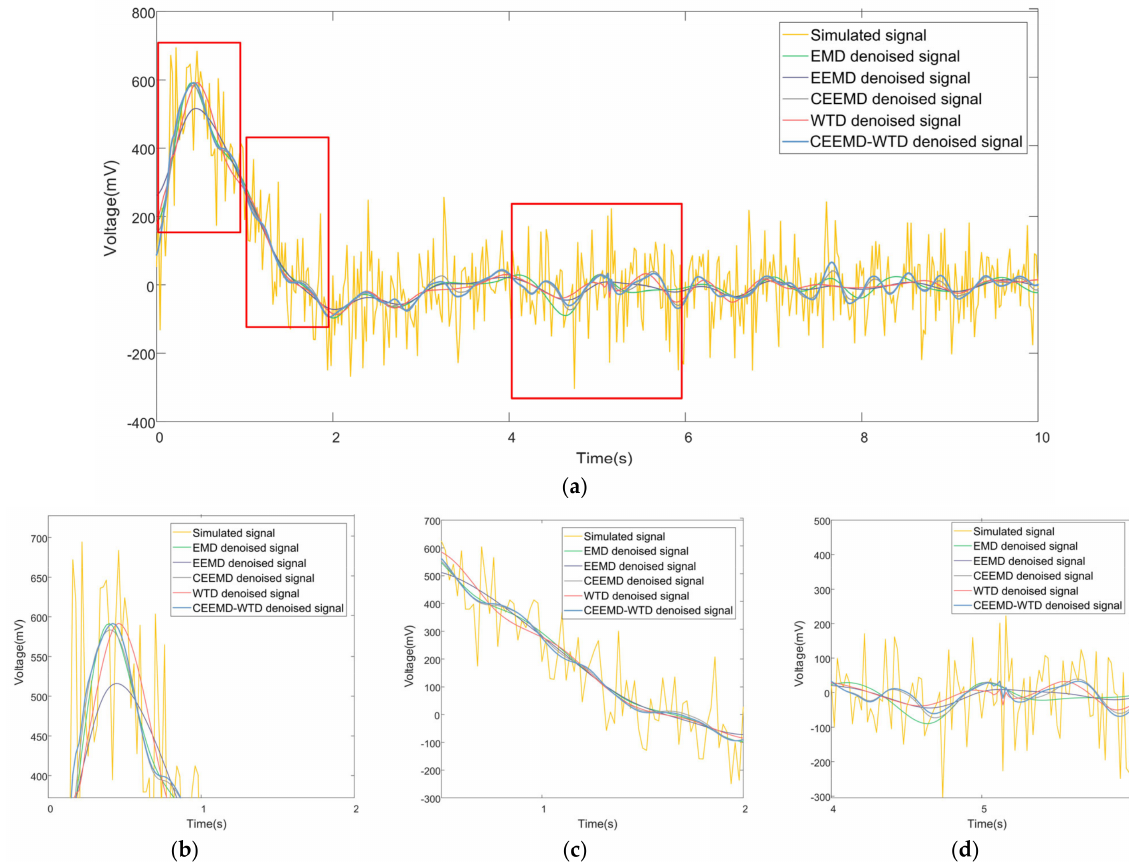
Figure 13. Time domain diagram of the simulated signal after denoising: ( a ) global signal; ( b ) locally amplified signals-1; ( c ) locally amplified signals-2; and ( d ) locally amplified